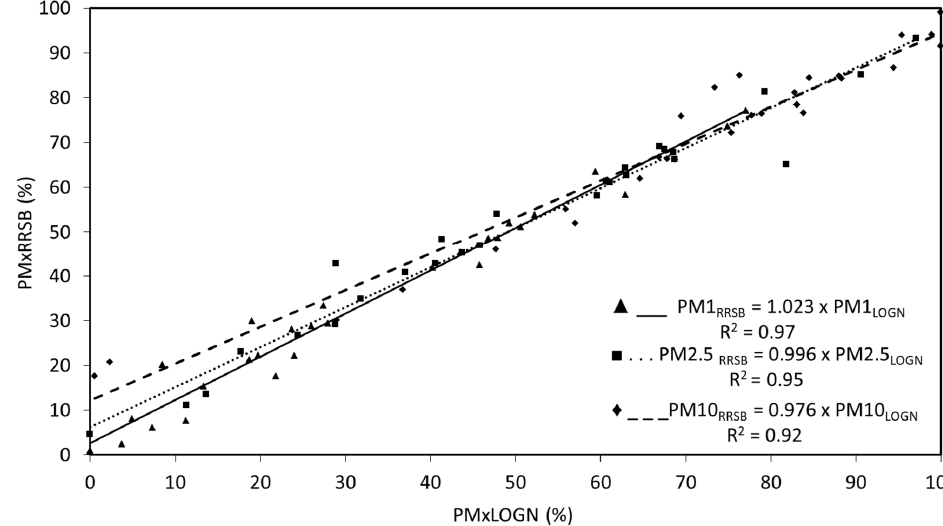
Figure 5. Granulometric fractions w 10 , w 2.5 , and w 1 calculated by the log-normal method and RRSB method.